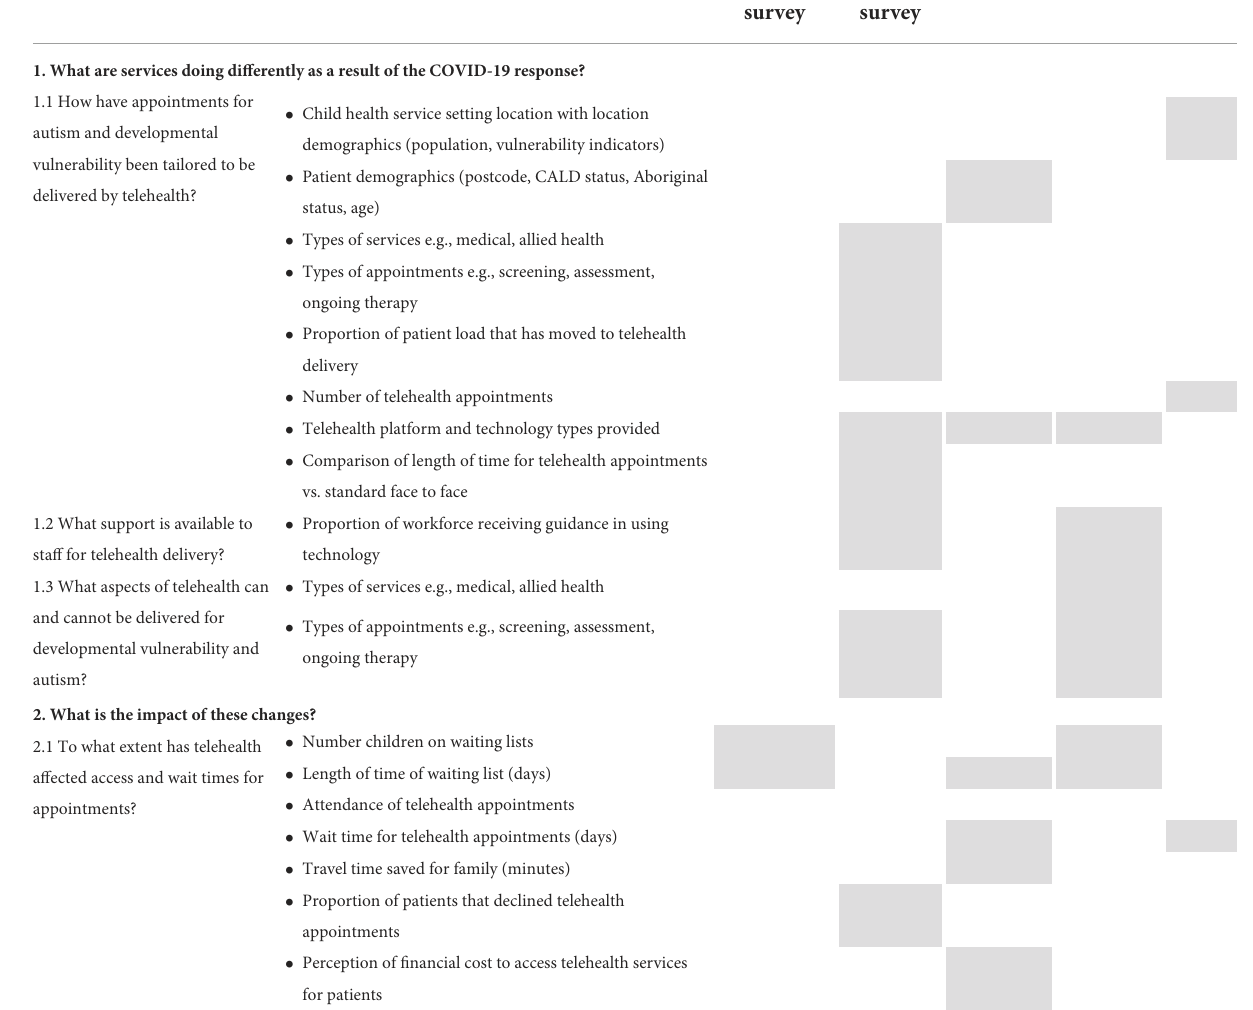
TABLE 5 Excerpt of organizing data matrix framework. Key evaluation